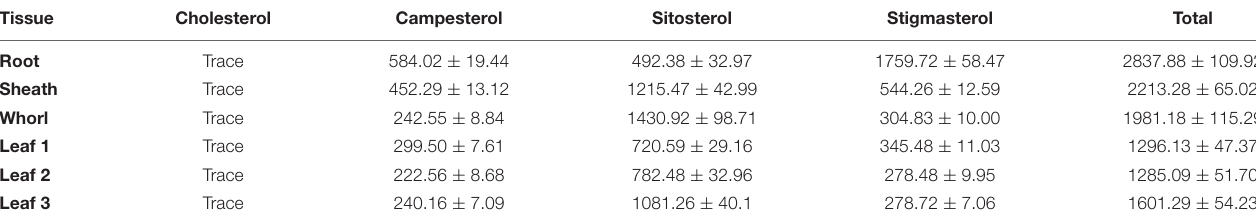
TABLE 1 | Free sterols content ( µ g g − 1 DW) in the various maize (B73) organs at V1 stage.